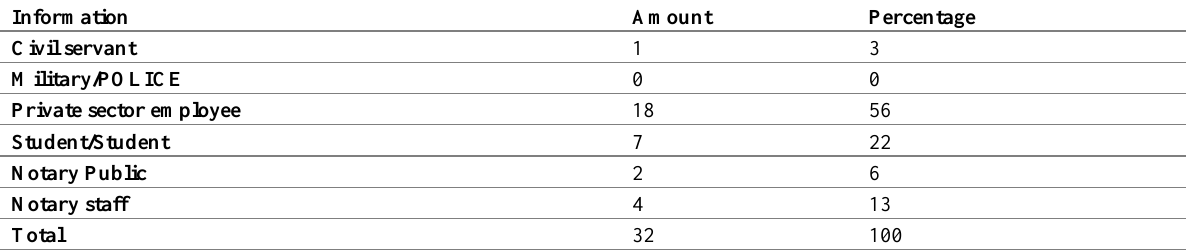
Table 4: Type of Respondent's